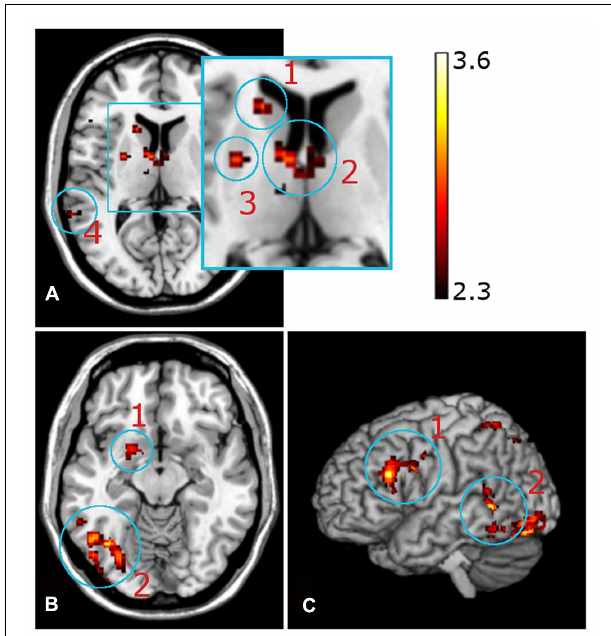
FIGURE 5 | Functional magnetic resonance imaging contrast for successfully encoded (later recognized) > unsuccessfully encoded (later forgotten) CRA solutions. (A) Axial view, z = 10, (a1) left caudate nucleus, (a2) anterior thalamus, (a3) putamen, (a4) inferior temporal gyrus. (B) Axial view, z = − 12, (1) amygdala, (b2) inferior temporal gyrus. (C) Sagittal view. (c1) inferior frontal gyrus, (c2) inferior/medial temporal gyrus.